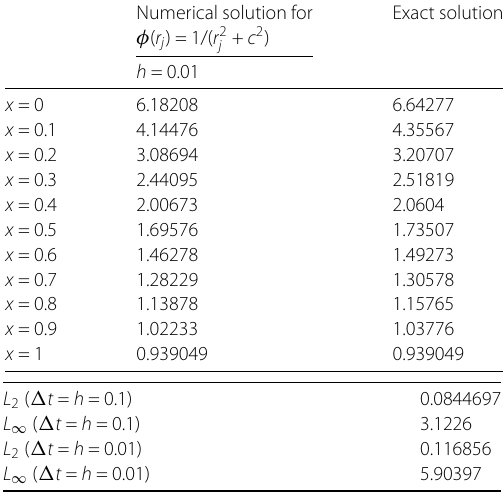
Table 1 Comparison of the error norms L 2 and L ∞ of the obtained solution using IQ radial basis for h = 0.1and h = 0.01 at c = 10 –15 , (cid:9) t = 0.01